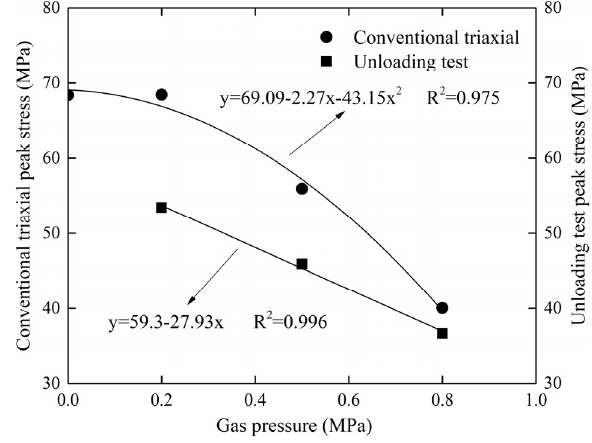
Figure 13. Relationship between peak stress and gas pressure.